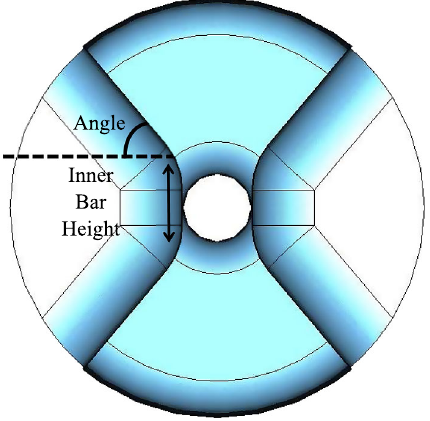
FIG. 25. Ratios of peak surface electric field ( E p ) and mag- netic field ( B p ) to the transverse electric field ( E t ) with varying angle and inner bar height of the trapezoidal-shaped parallel bars [Design